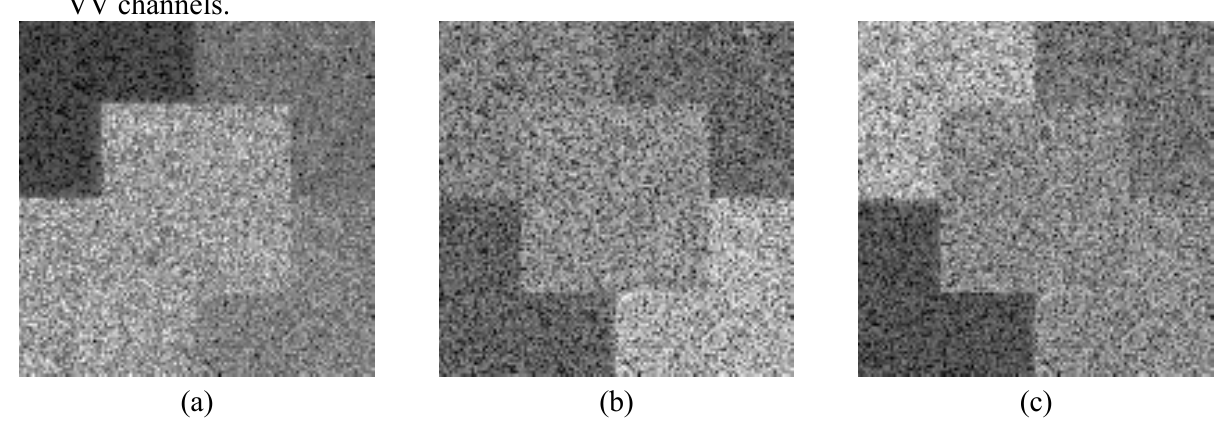
Figure 9. C-band amplitude simulated polarimetric SAR images: (a) HH, (b) HV and (c) VV channels.